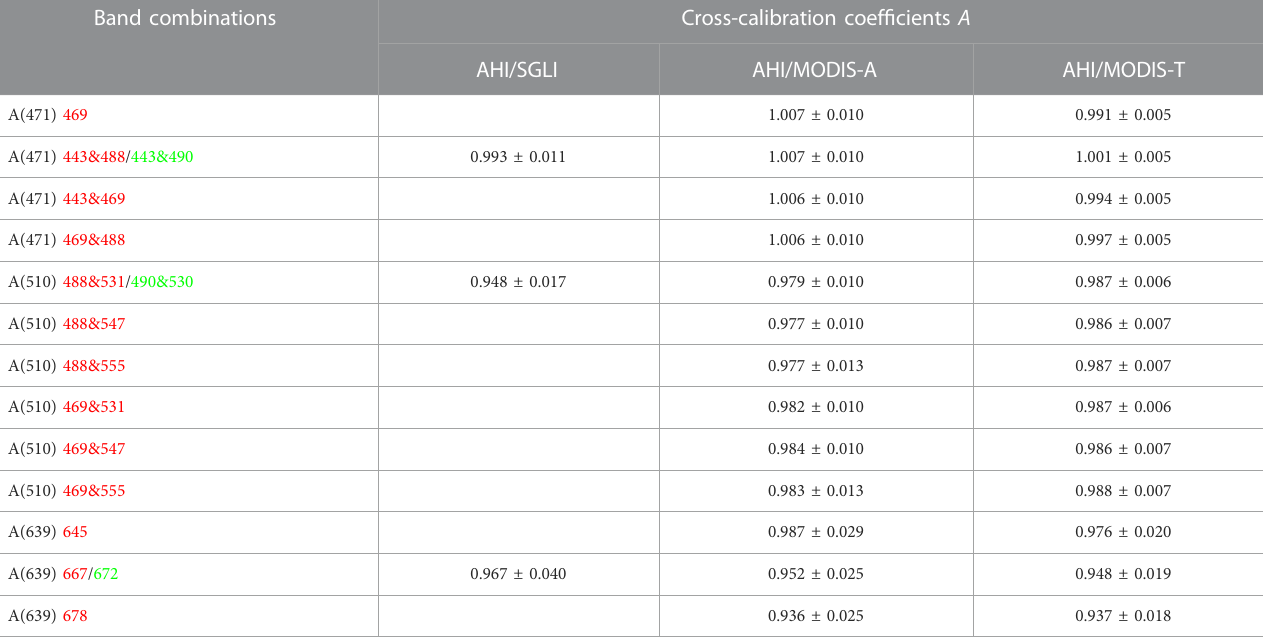
TABLE 7 Same as Table 6, but for coincidences obtained on 25 January 2020. Band